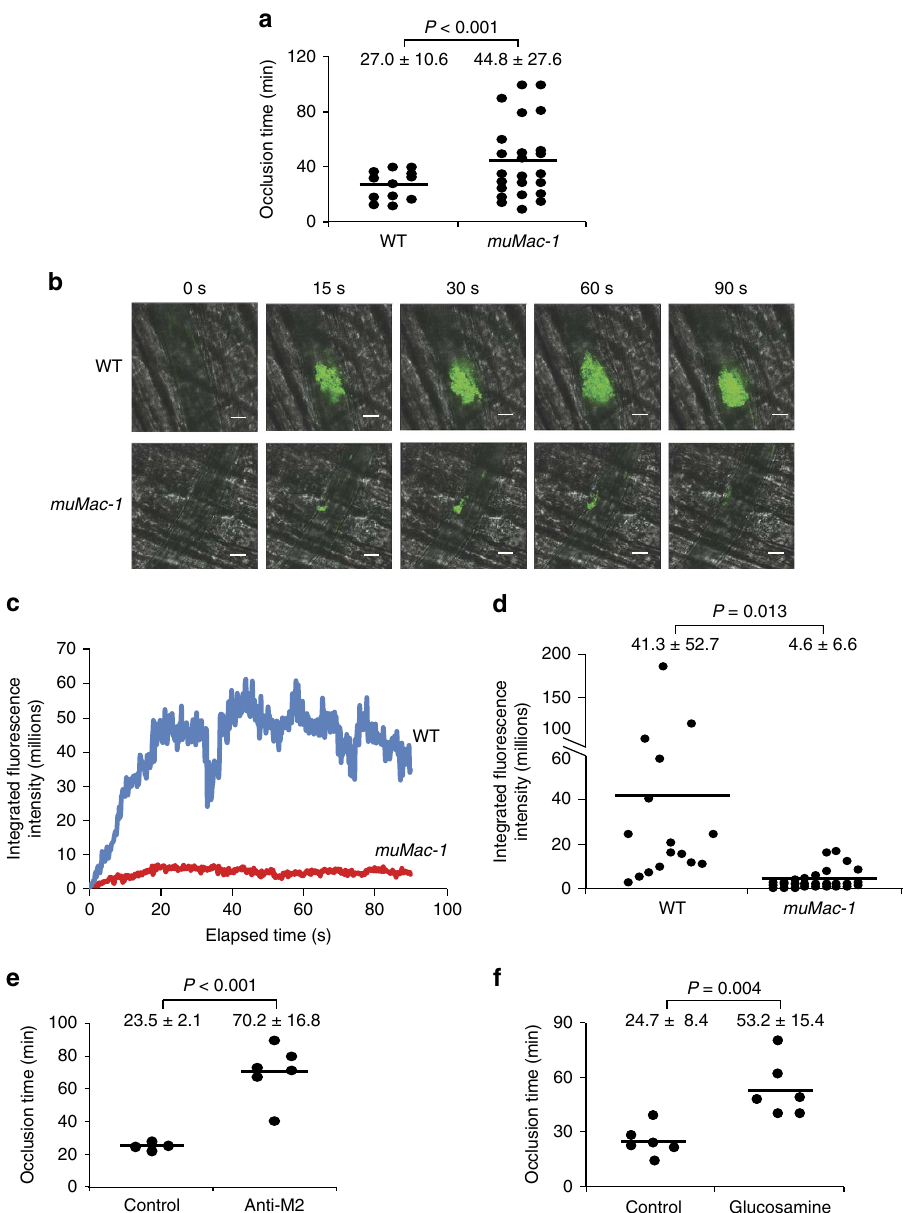
Figure 7 | Mac-1 regulates thrombus formation through its interaction with platelet GPIb a . ( a ) Occlusion times in WT ( n ¼ 12) and muMac-1 ( n ¼ 24) mice after carotid artery photochemical injury (mean ± s.d.). Thrombus formation after laser-induced injury to the arteriolar wall of the cremaster microvasculature of muMac-1 mice was compared with that of WTmice using intravital microscopy ( b – d ). Platelets were labelled in vivo using a fluorescein isothiocyanate-conjugated rat anti-mouse CD41 antibody. ( b ) Representative intravital images ( n ¼ 16 for WT and 31 for muMac-1 ) at indicated times following laser pulse. Scale bar, 20 m m. ( c ) Continuous, real-time thrombosis profiles of arterioles from one representative experiment. ( d ) Integrated fluorescence intensity of platelets in individual arterioles over time (WT: n ¼ 16; muMac-1 : n ¼ 31 arterioles; mean ± s.d.). ( e ) Occlusion times in mice treated with anti-M2 antibody that disrupts Mac-1-GPIb a binding or IgG control ( n ¼ 6 per group, mean ± s.d.). ( f ) Occlusion times in mice treated with